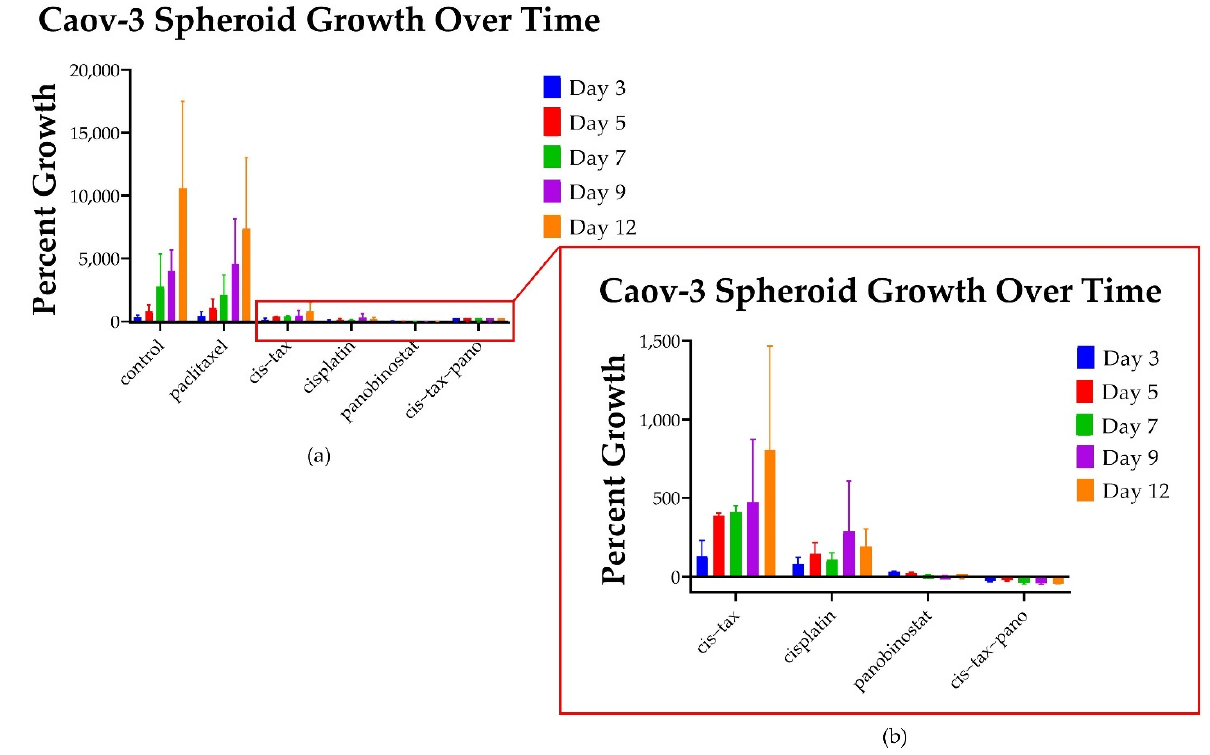
Figure 6. Graphic representation of the 3D growth of platinum-sensitive spheroids over time. ( a ) Spheroids exposed to paclitaxel on day 3 exceeded that of the control: Caov-3 spheroids demonstrated 293% growth (3-fold) under control conditions and 427% growth (4-fold) with paclitaxel alone ( p < 0.0001). However, the control spheroids grow to 10,000% (100-fold) their original size on day 12, whereas spheroids exposed to paclitaxel grow to 427% (4-fold) their original size. Spheroids exposed to cisplatin alone grow about 200% (2-fold) their original size. ( b ) The standard treatment, cis-tax, is more effective than paclitaxel alone, but still not as effective as the epigenetic therapy panobinostat, and especially in combination with standard chemotherapy. More effective than chemotherapy, the epigenetic therapy panobinostat not only curbed growth, but affected spheroid shrinkage, by 6% ( p < 0.0001) for panobinostat alone and 42% ( p < 0.0001) for the combination of cis–tax–pano ( p < 0.0001) ( n = 3).